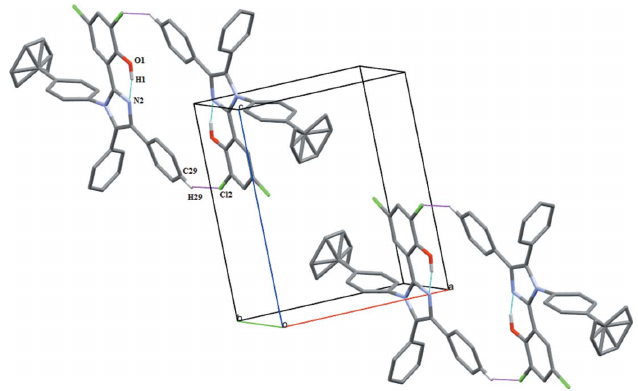
Figure 2 Unit-cell packing of the title compound showing intramolecular O— H (cid:3)(cid:3)(cid:3) N and intermolecular C—H (cid:3)(cid:3)(cid:3) Cl interactions with dotted lines. H atoms not involved in hydrogen bonding have been excluded.